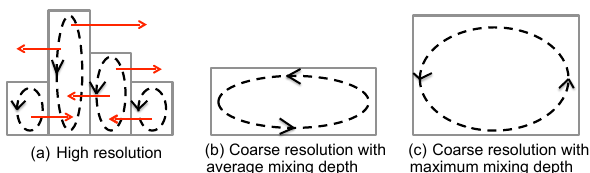
Figure 9. Effect of averaging high-resolution mixing depths in coarse-resolution simulations. (a) Mixing at high grid resolution; the vertical extents of the boxes denote mixing depths and the dashed arrows illustrate the mixing. Red arrows show the induced circulation for a chemical tracer emitted at the surface. (b, c) Mix- ing at coarse resolution with mixing depth taken as the average or the maximum of the high-resolution